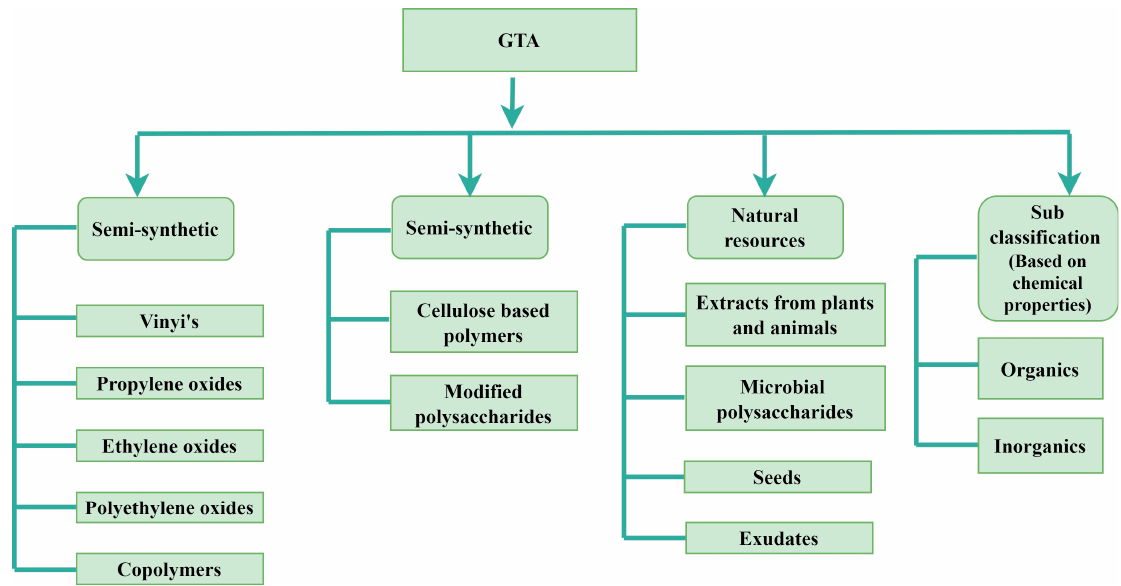
Figure 4. Overview of the GTA classi fi cations.